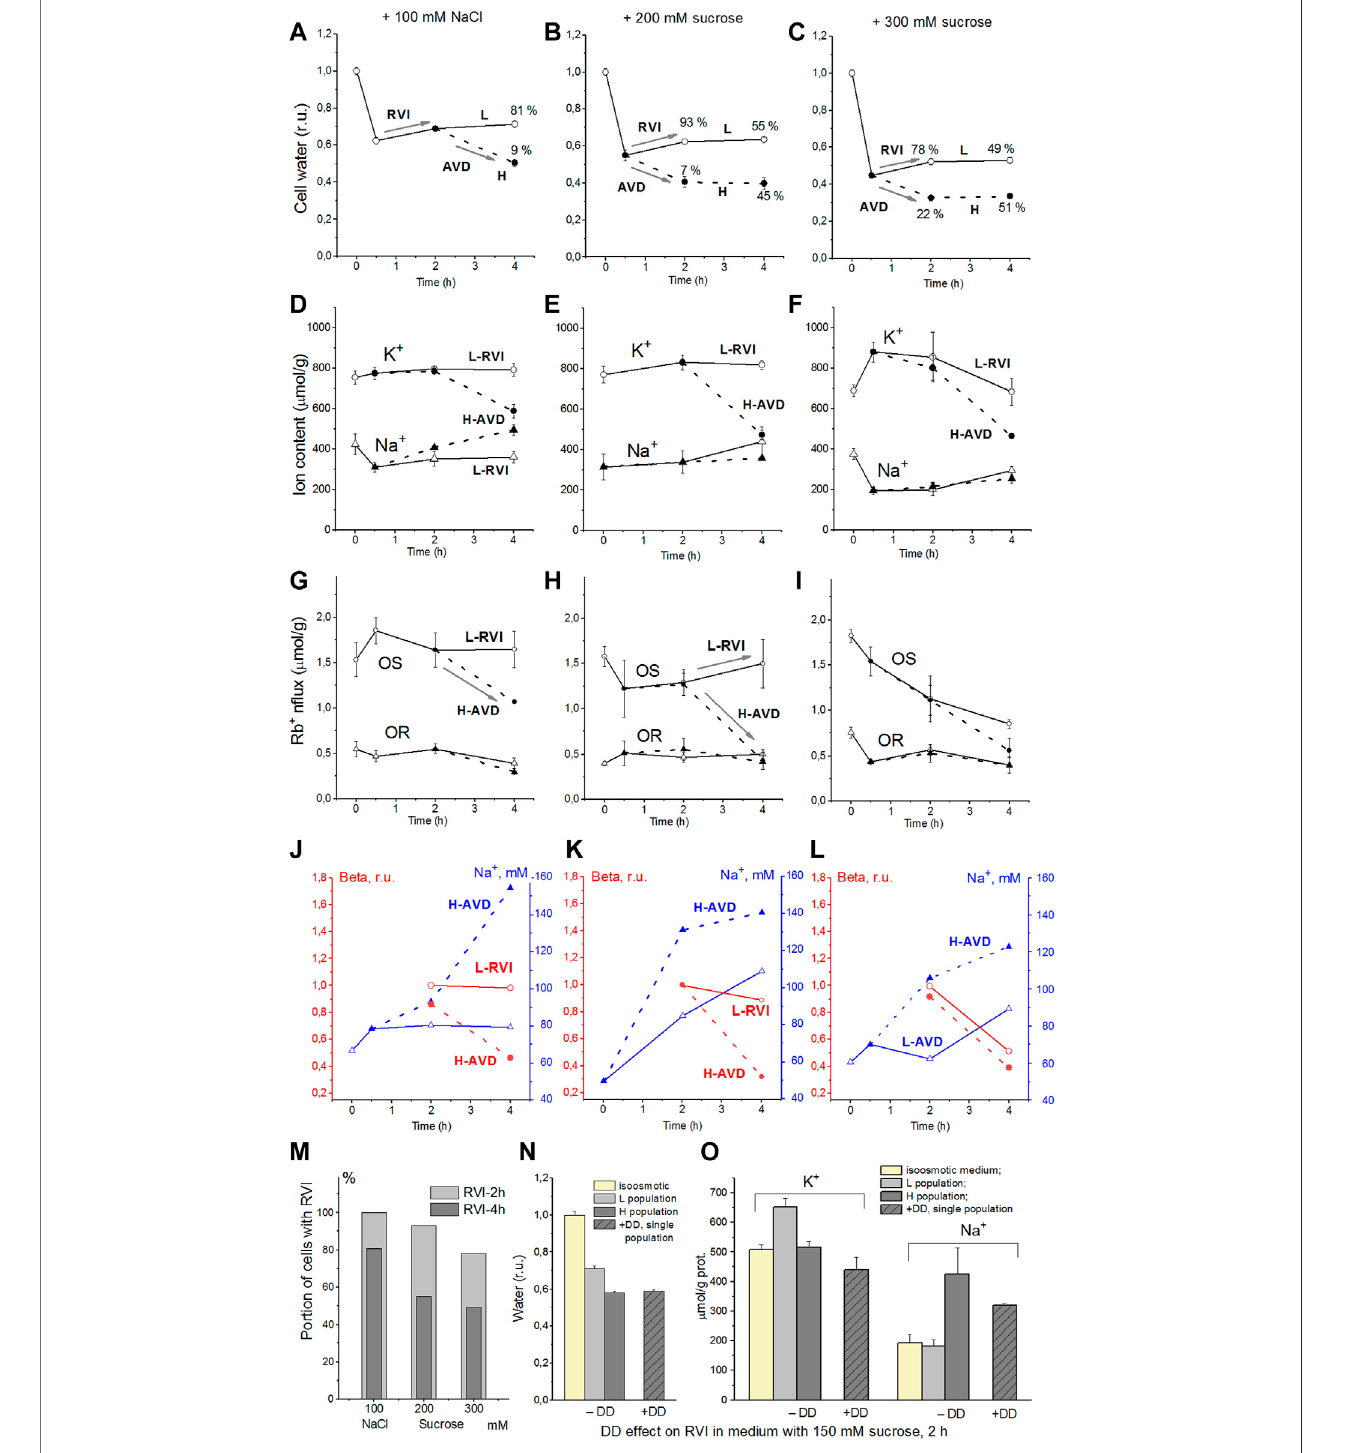
FIGURE 6 | Effect of hyperosmolar medium on living U937 cell. (A – C) cell water content, (D – F) intracellular K + , Na + content, (G – I) ouabain-sensitive (OR) and – resistant (OR) Rb + in fl uxes, (J – L) Na + concentrations and beta , (M) the percentage of cells with RVI (fraction L) after 2-h and 4-h incubation in a hyperosmolar medium assessed by protein, (N,O) DMA + DIDS (DD) effect on RVI in hyperosmolar medium with 150 mM sucrose. Solid lines with open symbols indicate light (L) cell subpopulation going RVI stage; dotted lines with fi lled symbols indicate heavy (H) cell subpopulation going AVD stage. Data at time zero represent cells in normal RPMImedium.Mean ± SEMvalueswerecalculatedfromatleastthreeindependentexperiments. (N,O) DMA(0.05 mM)andDIDS(0.5 mM)wereaddedsimultaneously with addition of 150 mM sucrose. From Yurinskaya et al., 2012 modi fi ed.